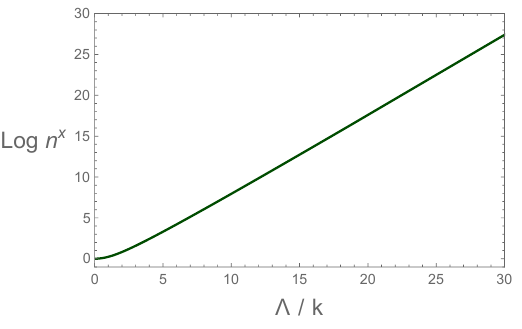
Figure 2 . The index of refraction, n x , for the BPS boomerang (cid:13)ows as a function of the dimen- sionless deformation parameter (cid:3) =k .